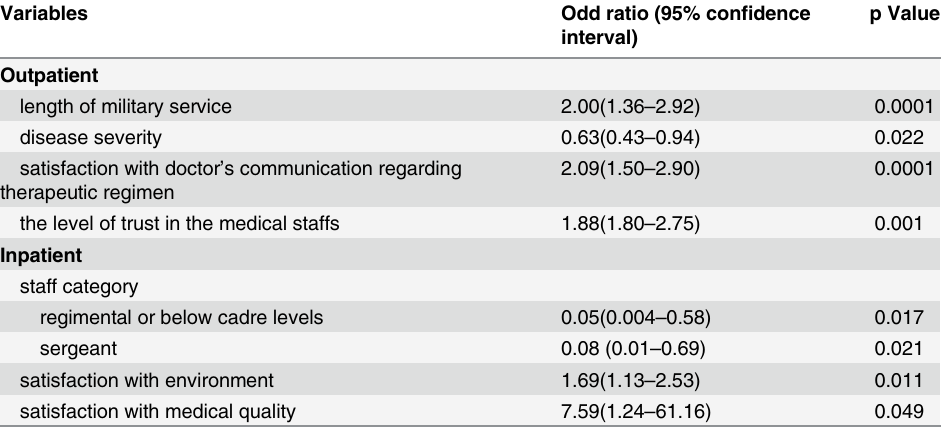
Table 4. Factors associated with overall outpatient satisfaction in the army after logistic regression